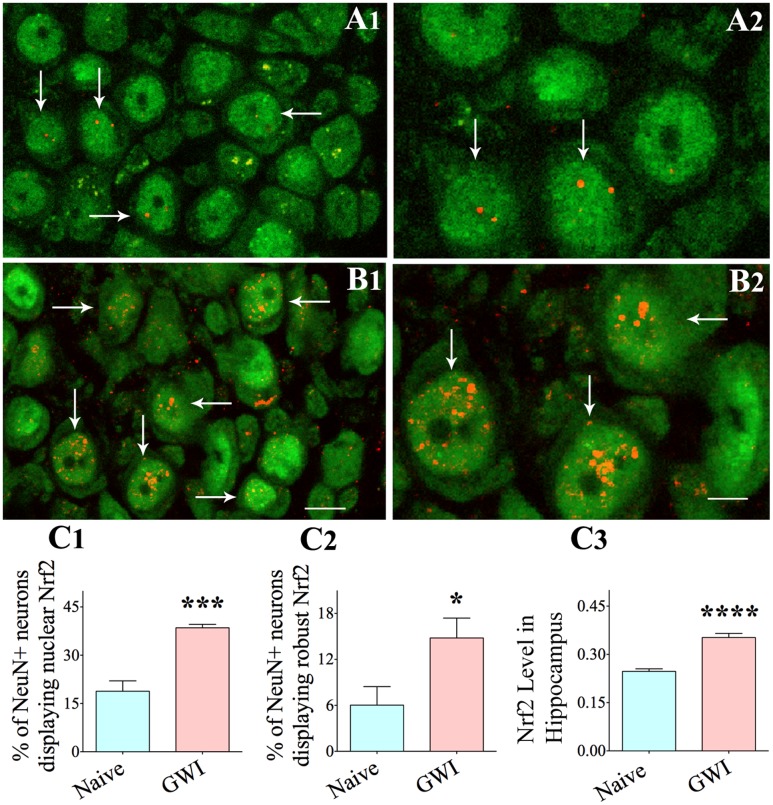
The hippocampus of rats with chronic gulf war illness-like symptoms (GWI-rats) exhibited an increased Nrf2 expression when evaluated 6 months after exposure to GWI-related chemicals and stress. Figures (A1–A4) illustrate examples of neuron specific nuclear antigen positive (NeuN+) hippocampal CA3 pyramidal neurons (green) displaying nuclear translocation of Nrf2 (red particles) in a naïve control animal (arrows in A1,A2) and in an animal exposed to GWI-related chemicals and stress (arrows in B1,B2). Note that nuclear translocation of Nrf2 is increased in the animal exposed to GWI-related chemicals and stress (B1,B2). Bar charts in C1–C3 compare percentages of NeuN+ hippocampal neurons displaying nuclear Nrf2 (C1), percentages of hippocampal neurons showing robust nuclear Nrf2 (C2) and the extent of activated Nrf2 measured through ELISA in the entire hippocampus between age-matched naïve control animals and animals exposed to GWI-related chemicals and stress (n = 5–6/group). Scale bar, (A1,B1), 10 μm; (A2,B2), 5 μm. ∗p < 0.05 ∗∗∗p < 0.001, ∗∗∗∗p < 0.0001.